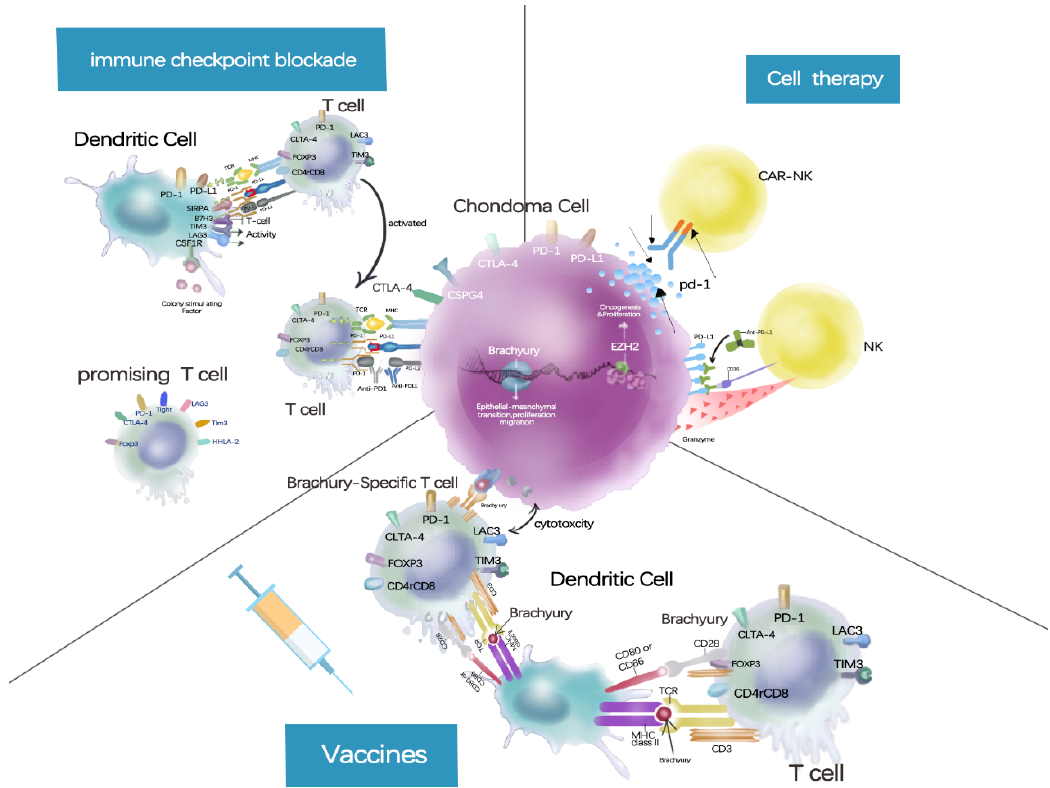
Figure 3. Vaccines , vaccines present brachyury antigens to dendritic cells, generating brachyury- specific T cells to kill tumor cells; Immune checkpoint blockade , immune checkpoints inhibitors enhance the killing effect of immune cells to tumors by targeting PD-1, PD-L1, CTLA-4 and other targets; Cell therapy , Immune cells modified with chimeric antigen receptors can recognize tumor antigens and kill